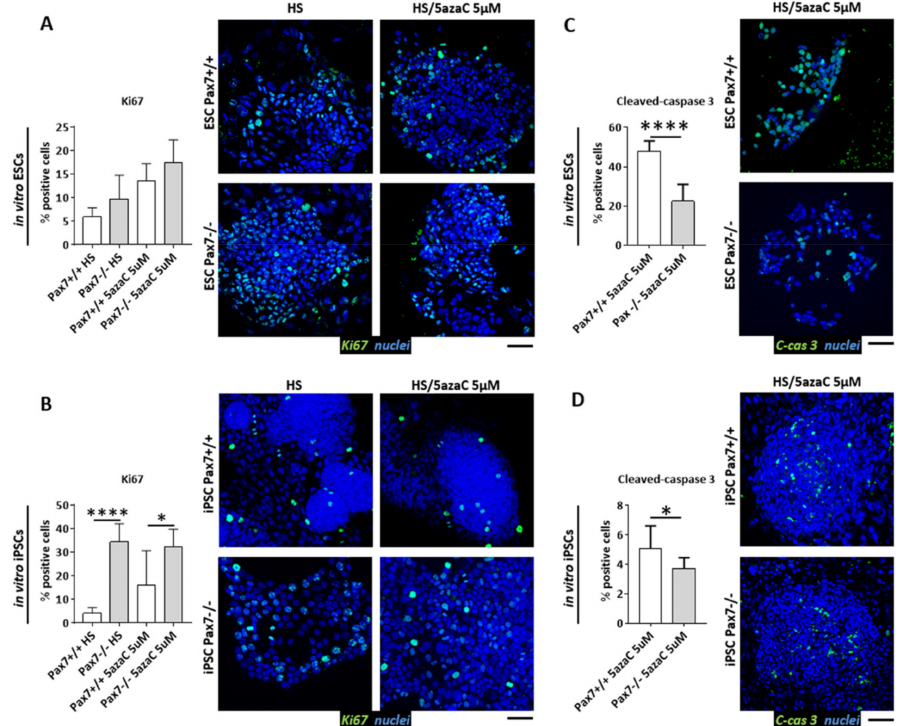
Figure 4. Cell proliferation and apoptosis in differentiating Pax7 +/+ and Pax7 − / − ESCs and iPSCs treated with HS and 5-azacytidine. ( A ) Proportion of Ki67 positive (Ki67+) cells and immunolocal- ization of Ki67 (green) and nuclei (blue) in ESCs. Scale bar 100 µ m. ( B ) Proportion of Ki67 positive (Ki67+) cells and immunolocalization of Ki67 (green) and nuclei (blue) in iPSCs. Scale bar 100 µ m. ( C ) Proportion of cleaved-caspase 3 (C-cas 3) positive cells and immunolocalization of cleaved- caspase 3 (green) and nuclei (blue) in ESCs. Scale bar 100 µ m. ( D ) Percentage of cleaved-caspase 3 (C-cas 3) positive cells and immunolocalization of cleaved-caspase 3 (green) and nuclei (blue) in iPSCs. Scale bar 100 µ m. White bars—values for Pax7 +/+ PSCs; gray bars—values for Pax7 − / − PSCs. Data are presented as mean ± SD. ( A , B ) Stars symbolize result of two-way ANOVA and post-hoc Sidak’s multiple comparisons test: * p < 0.05, **** p < 0.0001. ( C , D ) Stars symbolize results of Student’s unpaired two-tailed t -test: * p < 0.05, **** p < 0.0001.